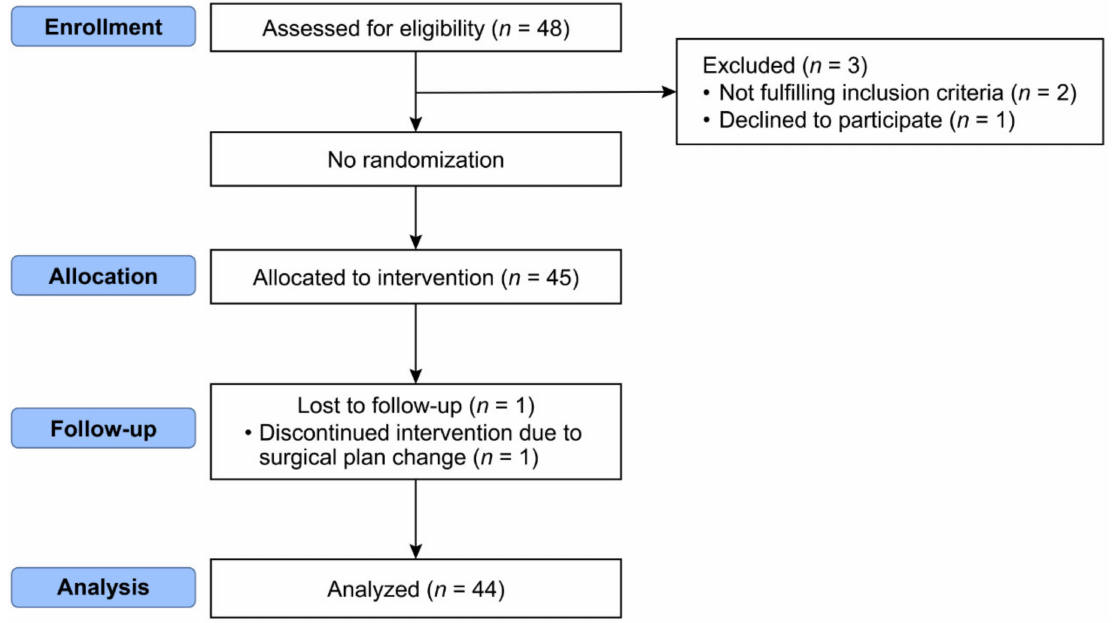
Figure 1. Consort flow diagram.